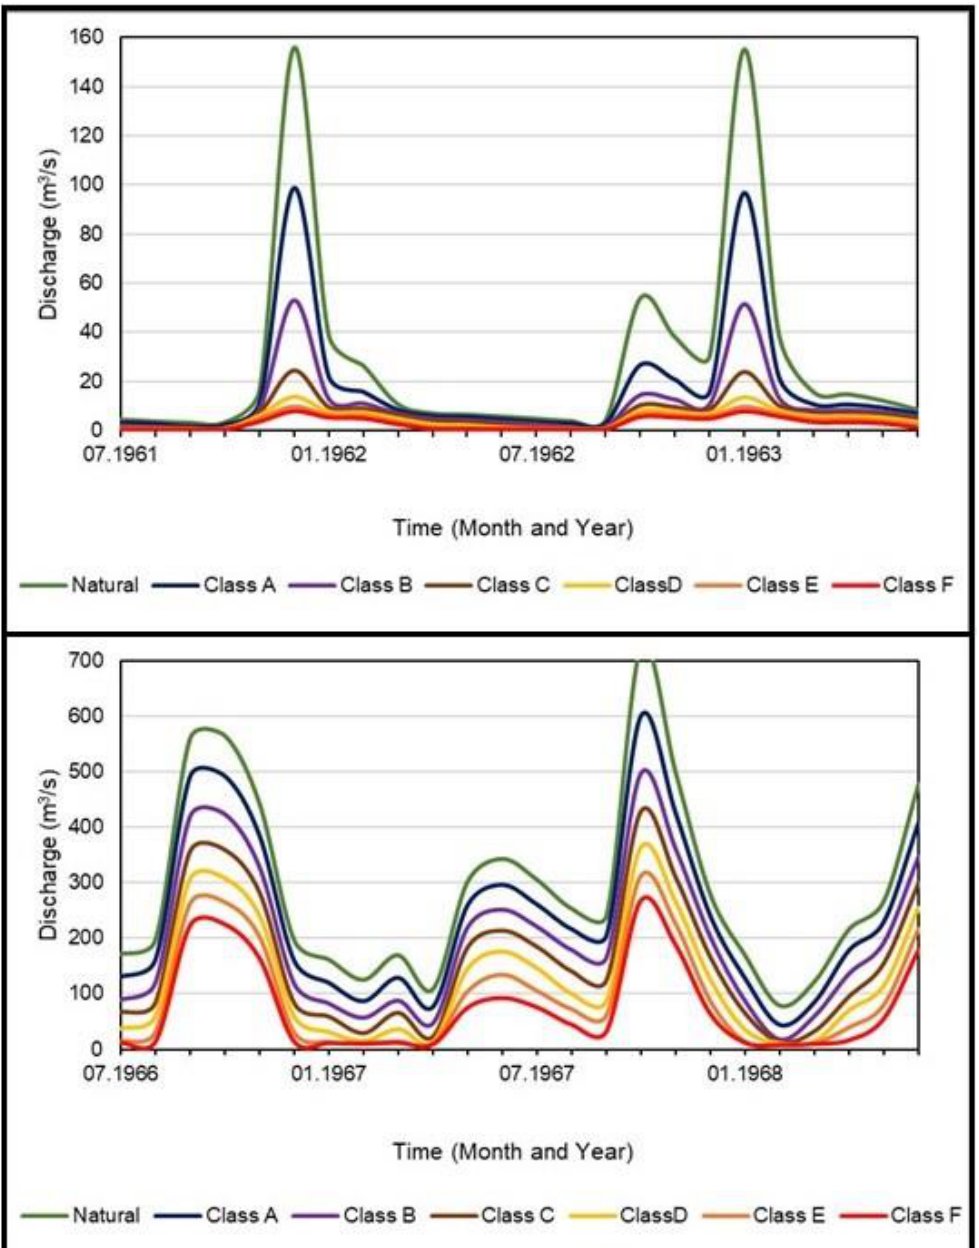
Figure 4. Extracts from Environmental Flow time series required at the outlets of Malwatu Oya ( top ) and Kalu Ganga ( bottom ) for the rivers to be maintained in six Environmental Management Classes (EMCs). Table 2. Environmental Flow (EF) Yield requirement at the downstream end of Malwatu Oya and Kalu Ganga basins under seven EF release scenarios.